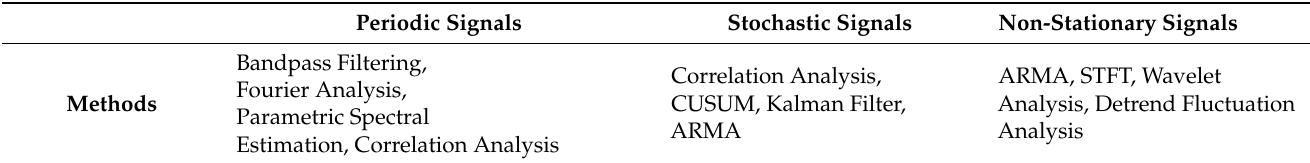
Table 1. Classification of methods based on signals according to the nature of the signal to be used for the